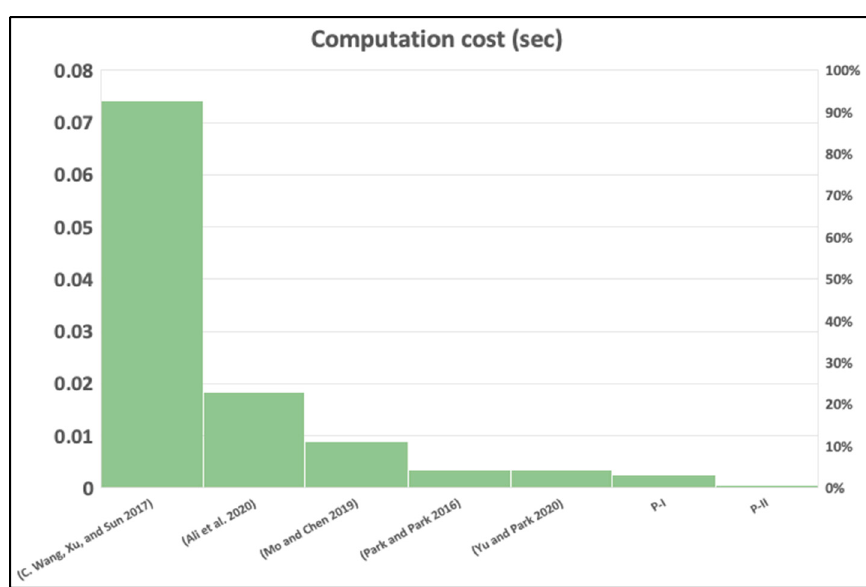
Figure 17. Computation time in hub node. Table 4. Rough estimated time for various schemes (He et al. 2014).